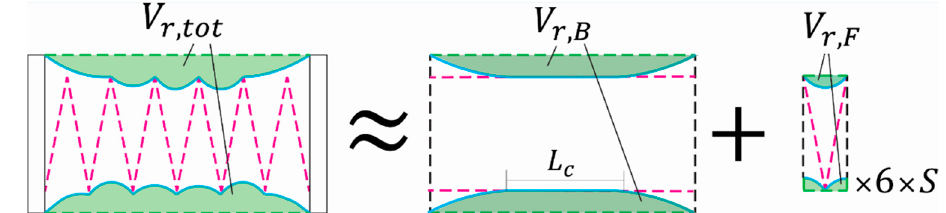
Figure 4. Schematic of the two geometrically-based models for approximating the volume loss of the actuator throughout its contraction, showing the bellows and FOAM models labeled with the B and F subscripts, respectively. The volume loss from the FOAM model is multiplied by six and a scaling factor proportional to L c .